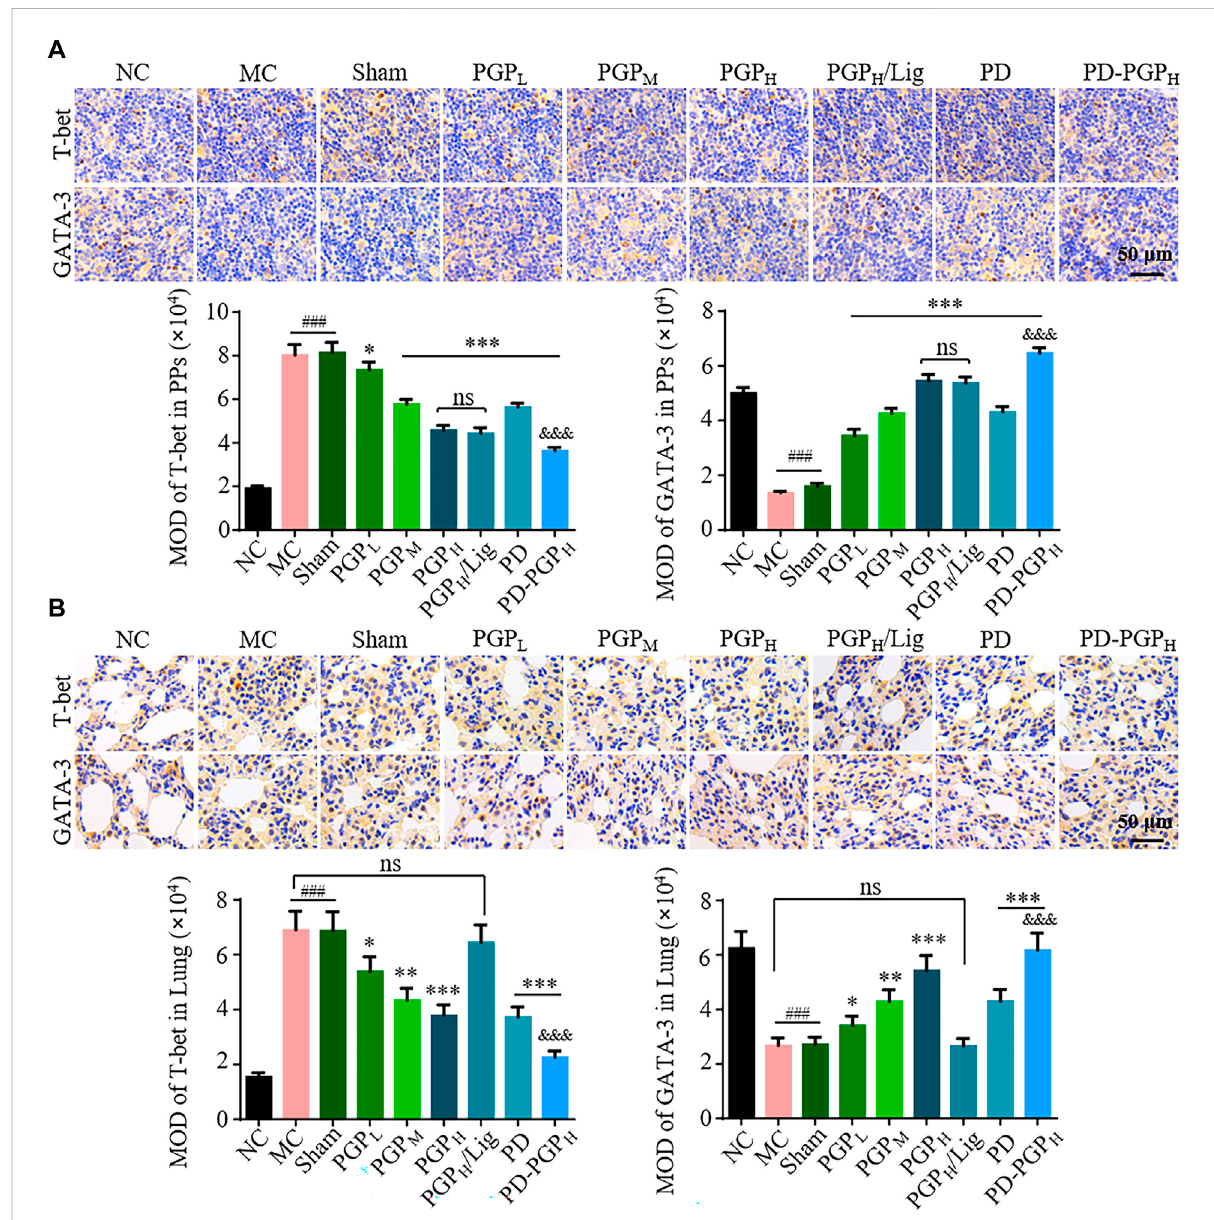
CBrats,after90 minintestinalperfusionofPGP(groupsPGP L/M/H ),PD(groupPD),andPD-PGP(groupsPD-PGP H ),with(groupPGP H /Lig)orwithout mesenteric lymphatic vessel ligation. T-bet and GATA-3 expression in PPs and lung tissues from normal (groups NC), model (group MC), and sham- operated (group Sham) rats were set as the comparison. (Original magni fi cation ×200. Data are expressed as mean ± SD, with data obtained from 10 randomly selected fi elds. Data are expressed as mean ± SD ( n = 6); * p < 0.05, ** p < 0.01 and *** p < 0.001 versus MC group; ### p < 0.001 versus NC group; &&& p < 0.001 versus PD